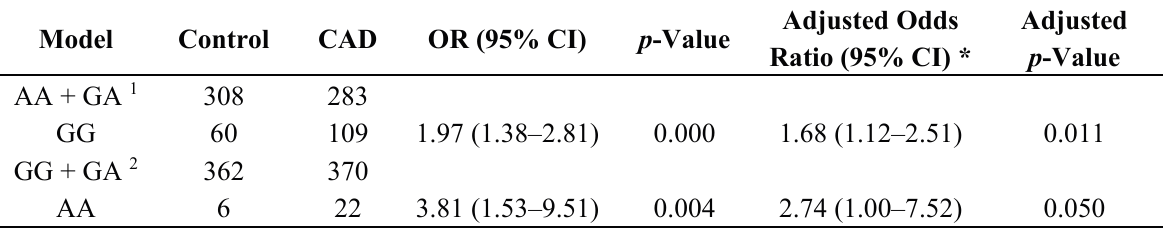
Table 3. Association between RBP4 polymorphic genotypes and the risk of CAD.